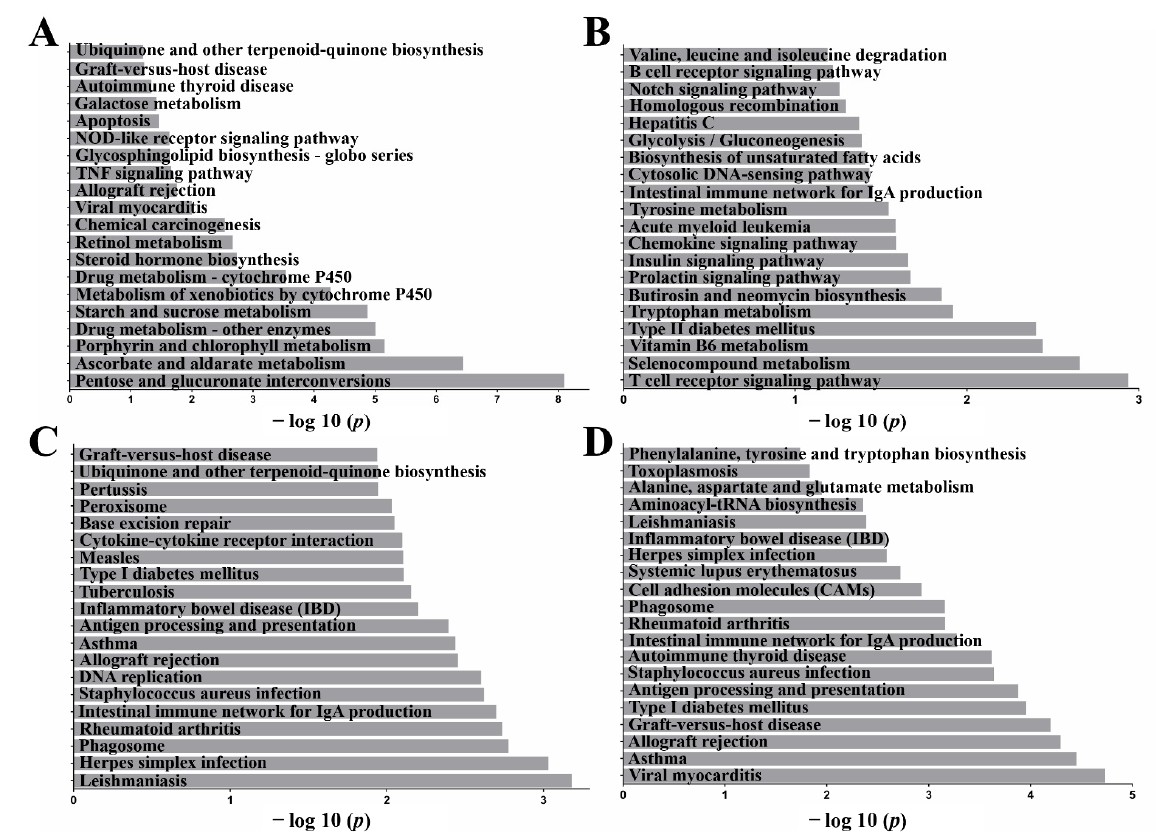
Figure 3. Pathways of the Top 20. The enrichment factor represents the ratio between the differentially expressed gene and all annotated lncRNA target genes enriched in the pathways of the top 20. Co-location prediction of lncRNAs between ( A ) S.T group and control, ( B ) S.T group and AA + S.T group. KEGG analysis was performed on the mRNAs identified by searching for genes within 100 kb upstream and downstream of the lncRNA. Prediction of co-expression of lncRNAs between ( C ) S.T group and control, ( D ) S.T group and AA + S.T group. KEGG analysis was performed on mRNAs obtained by analyzing expression correlations among multiple samples.